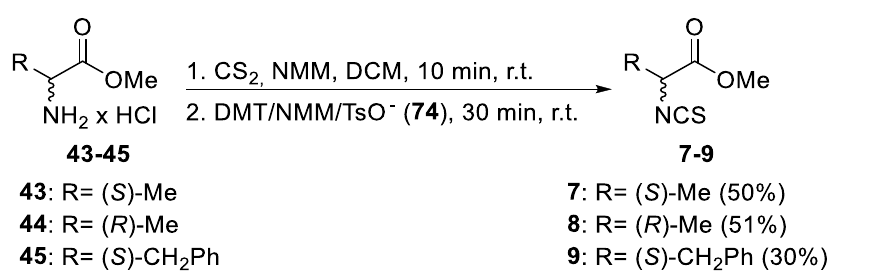
Scheme 2. Method B: microwave-assisted synthesis of isothiocyanates 29 and 30 using DMT/NMM/TsO − ( 74 ) as desulfurating reagent.